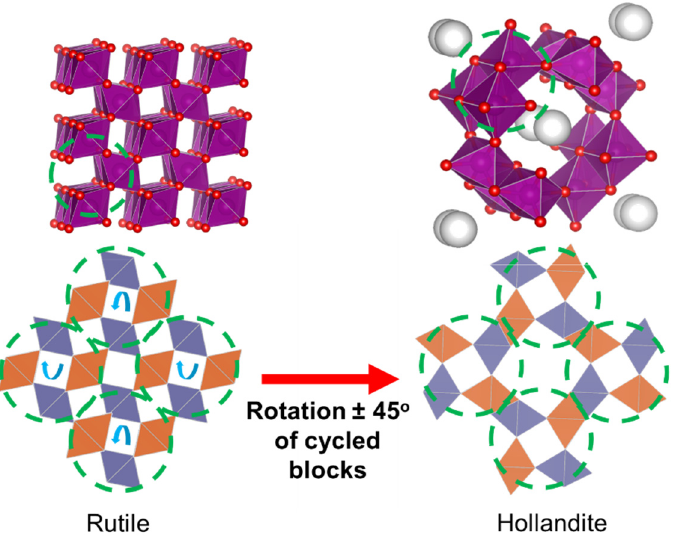
Figure 2. Scheme for the transformation of rutile into hollandite by rotating the blocks enclosed in a circle clockwise or counterclockwise (turn indicated by the blue arrows). As an explanatory note, orange octahedral units are placed in a different plane with respect to blue units. Adapted from [83].